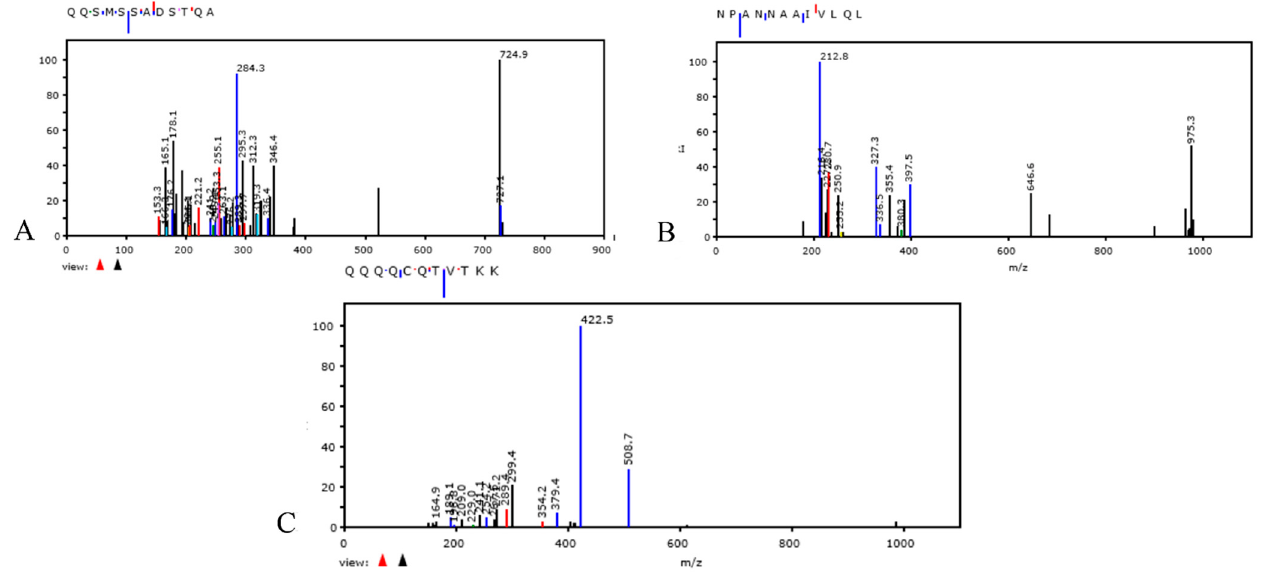
Figure 4. Panels ( A – C ): show the MS/MS spectra of the nucleocapsid protein of SARS-CoV-2 containing the nitrogen isotope. Panel ( A ) shows peptide seq: QQSMSSADSTQA; ID:|A0A8B1JYE4|A0A8B1JYE4_SARS2; Mods: Q408 + 1 ( 13 C) + 2 ( 15 N), Q409 + 1 ( 13 C) + 2 ( 15 N). Panel ( B ) shows peptide seq: NPANNAAIVLQL; ID: A0A7M1YDW6|A0A7M1YDW6_SARS2; Mods: Q160 + 1 ( 13 C) + 2 ( 15 N). Panel ( C ) shows peptide seq: QQQQCQTVTKK; ID:|A0A8B1XSI6|A0A8XSI6_SARS2; Mods: Q239 + 1 ( 13 C) + 2 ( 15 N), Q239+Ammonia-loss, Q240 + 1 ( 13 C) + 2 ( 15 N), Q241 + 1 ( 13 C) + 2 ( 15 N), Q242 + 1 ( 13 C) + 2 ( 15 N), Q244 + 1 ( 13 C) + 2 ( 15 N).